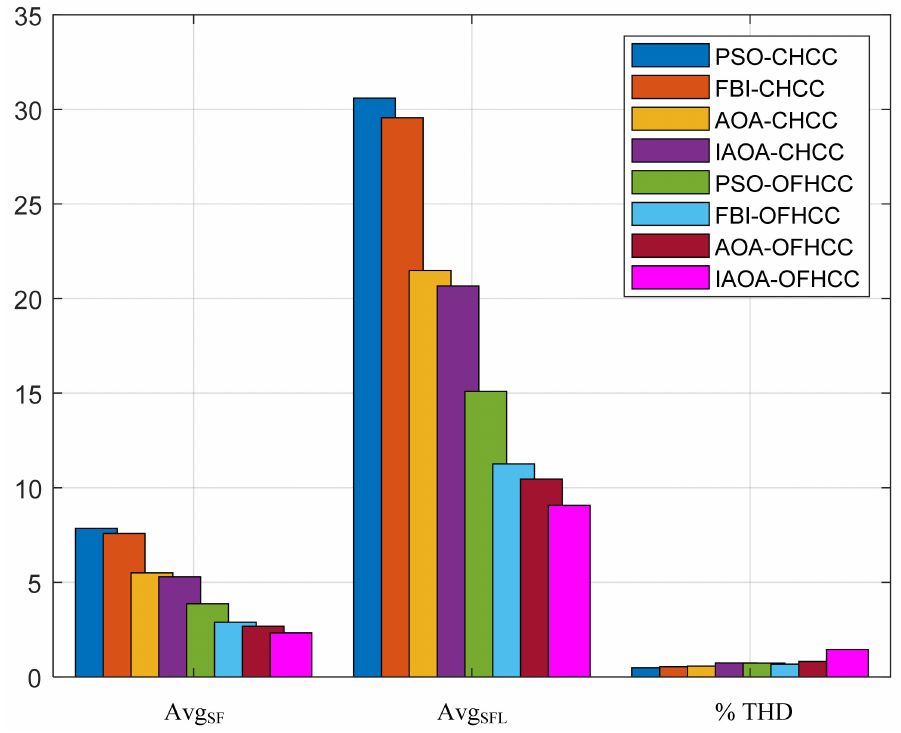
Figure 23. Bar plot of various performance indices for different